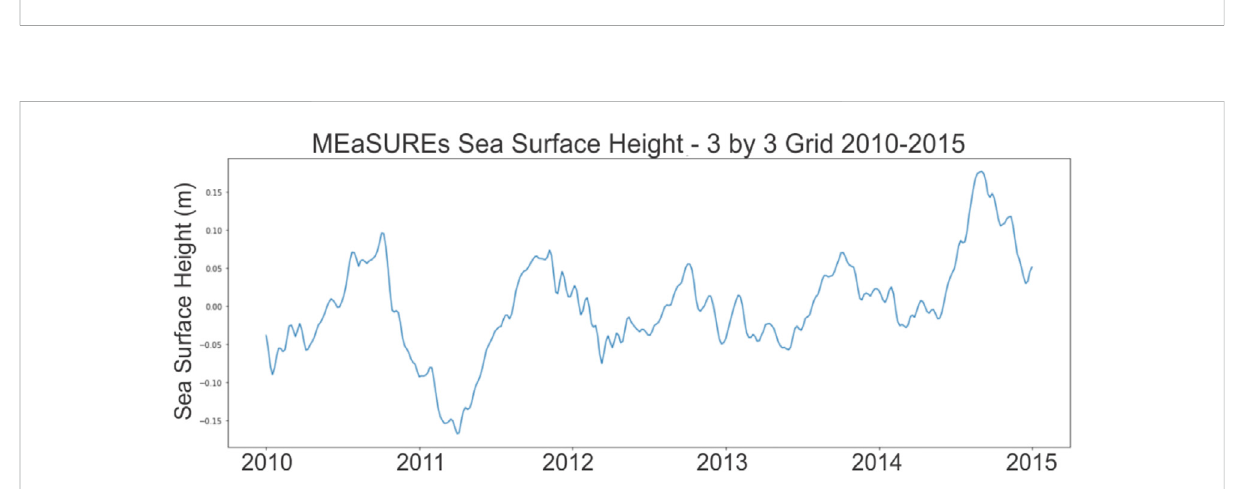
FIGURE 10 Wind data from eastern coastline buoy (Tillamook) and western open ocean buoy (C46) suggest that coastal winds varied more than open ocean winds. Neither case shows a simple progressive change in direction from 2010 to 2014.